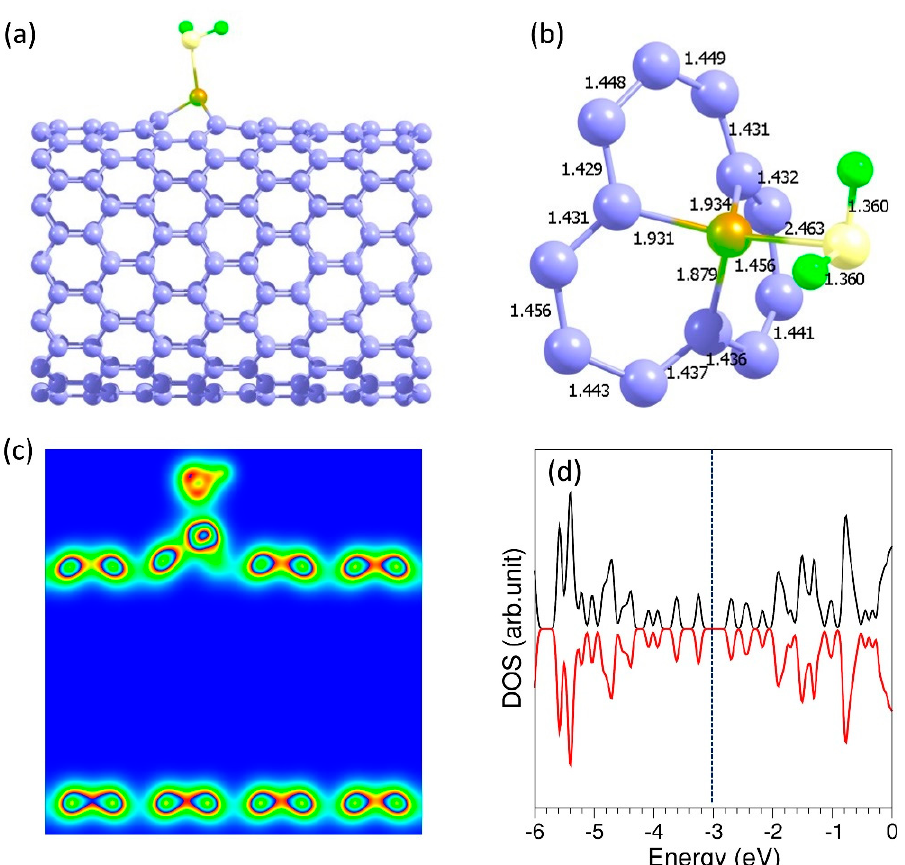
Figure 6. ( a ) Relaxed structure of a single H 2 S molecule adsorbed on the surface of Ru-doped SWNT, ( b ) side view of the relaxed configuration showing the Ru-C and Ru-S bond distances measured in Angström, ( c ) charge density plot showing the interaction of H 2 S molecule with the nanotube, and ( d ) the total DOS plot of the adsorbed configuration. Vertical dashed lines correspond to the Fermi level.